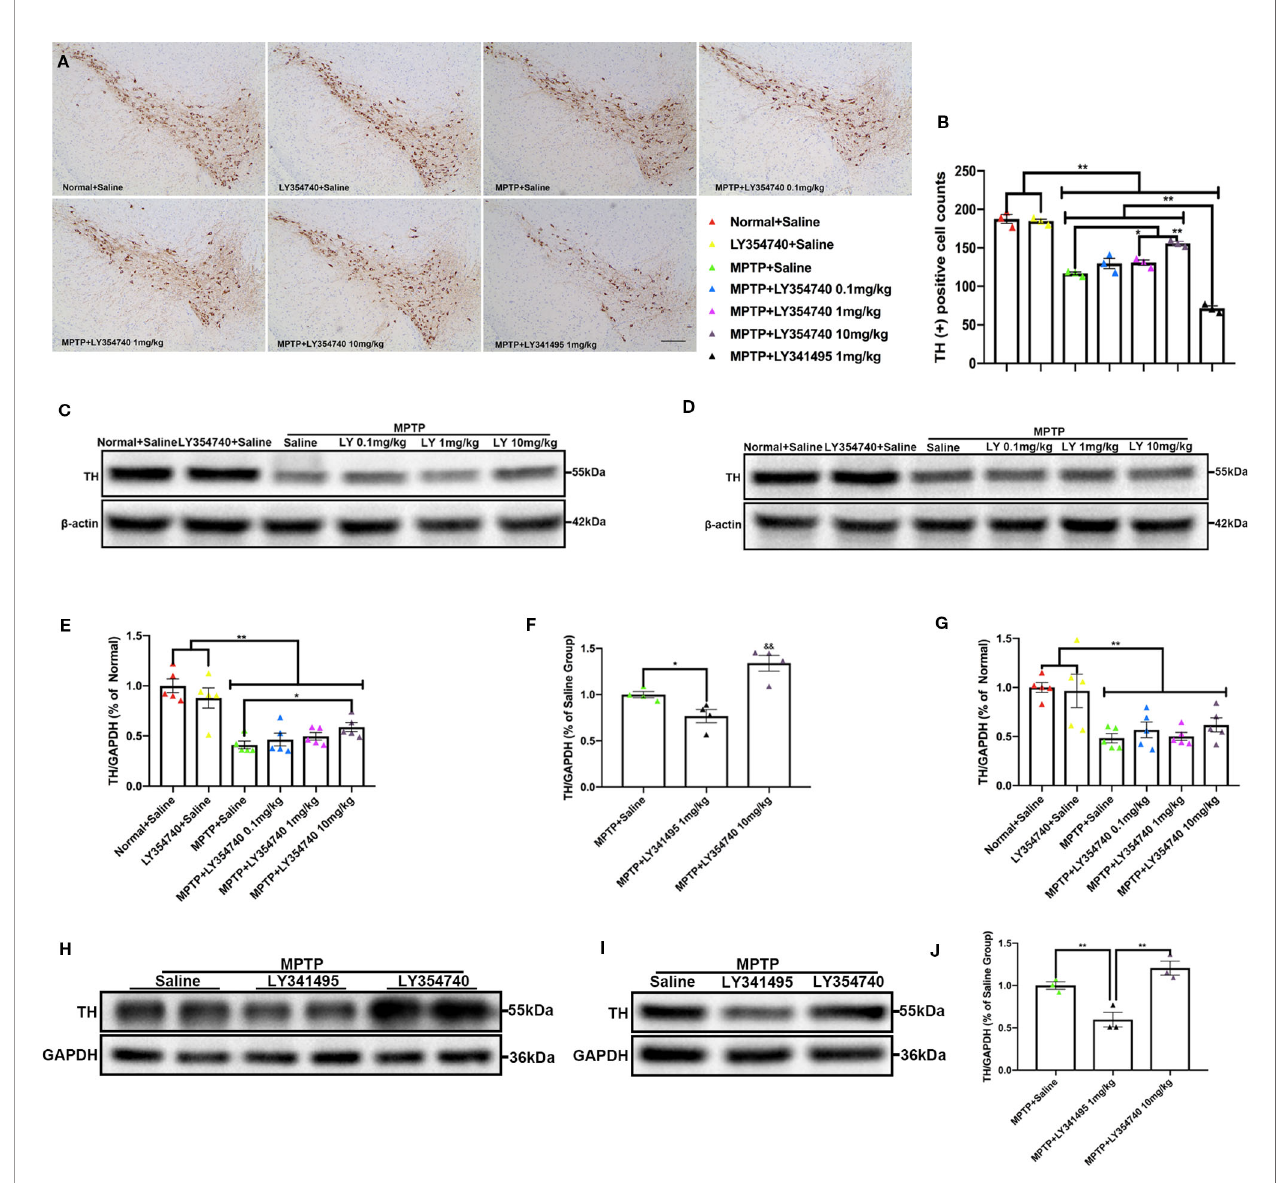
FIGURE 3 | Ligands of mGlu 2/3 receptors in fl uence expression of tyrosine hydroxylase (TH) in striatum and substantia nigra (SN) of sub-acute 1-methyl-4-phenyl- 1,2,3,6-tetrahydropyridine (MPTP)-treated mice. (A , B) Immunohistochemical images and corresponding TH positive cell counts in SN from each group. Scale bar = 100 m m. All data were expressed as % of the normal + saline group. *p < 0.05, **p < 0.01. N = 3 per group. Error bars represent SEM. (C, E, F, H) Immunoblots present the levels of TH in SN of each group. * p < 0.05, **p < 0.01; && p < 0.01 vs. the other the two groups. N = 5 per group in (E) ; N = 4 per group in (F) . (D, G, I, J) Relative quanti fi cations of expression of TH in striatum of each group were presented. **p < 0.01. N = 5 per group in (G) ; N = 3 per group in (J) . The band intensity of particular target proteins was normalized to glyceraldehyde 3-phosphate dehydrogenase (GAPDH) or b -actin level. Data in (E, G) were expressed as % of normal + saline group. Data in (F, J) were expressed as % of the MPTP + saline group. Error bars represent